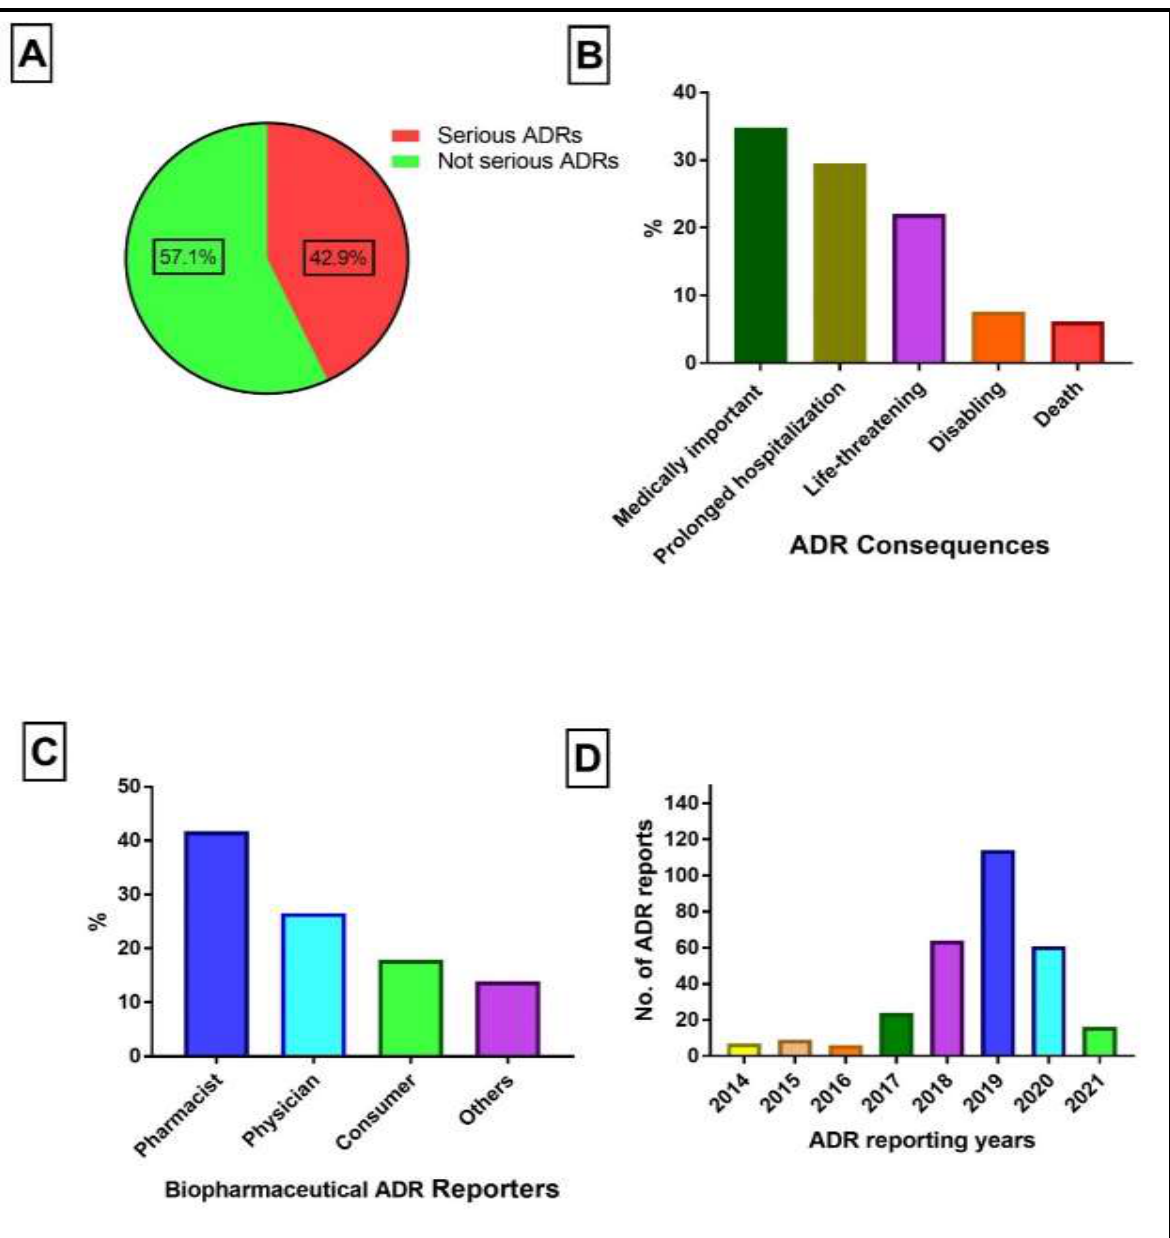
Figure 1. The descriptions of the reported biopharmaceutical ADRs to the